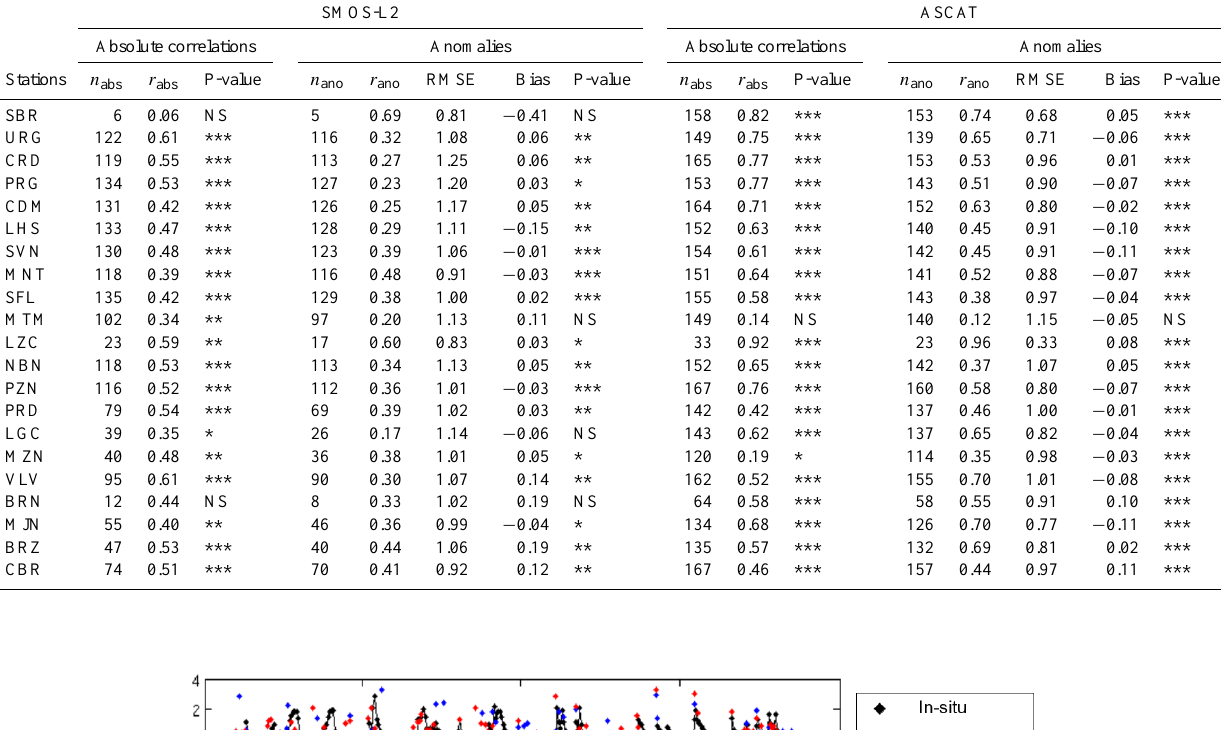
Table 2. Comparison of SMOS-L2 and ASCAT SSM anomalies with the in-situ SSM ( − 5cm) anomaly measured at 21 ground stations for the year 2010: correlation ( r ano ), mean bias (in-situ minus satellite products), root mean square error (RMSE) and p-value. The number of data used to calculate the scores is given ( n ano ). Absolute correlations ( r abs ) are indicated. NS stands for non significant, and *, **, *** stand for p-values greater than 0.05, between 0.05 and 0.001, and between 0.001 and 0.0001, respectively.